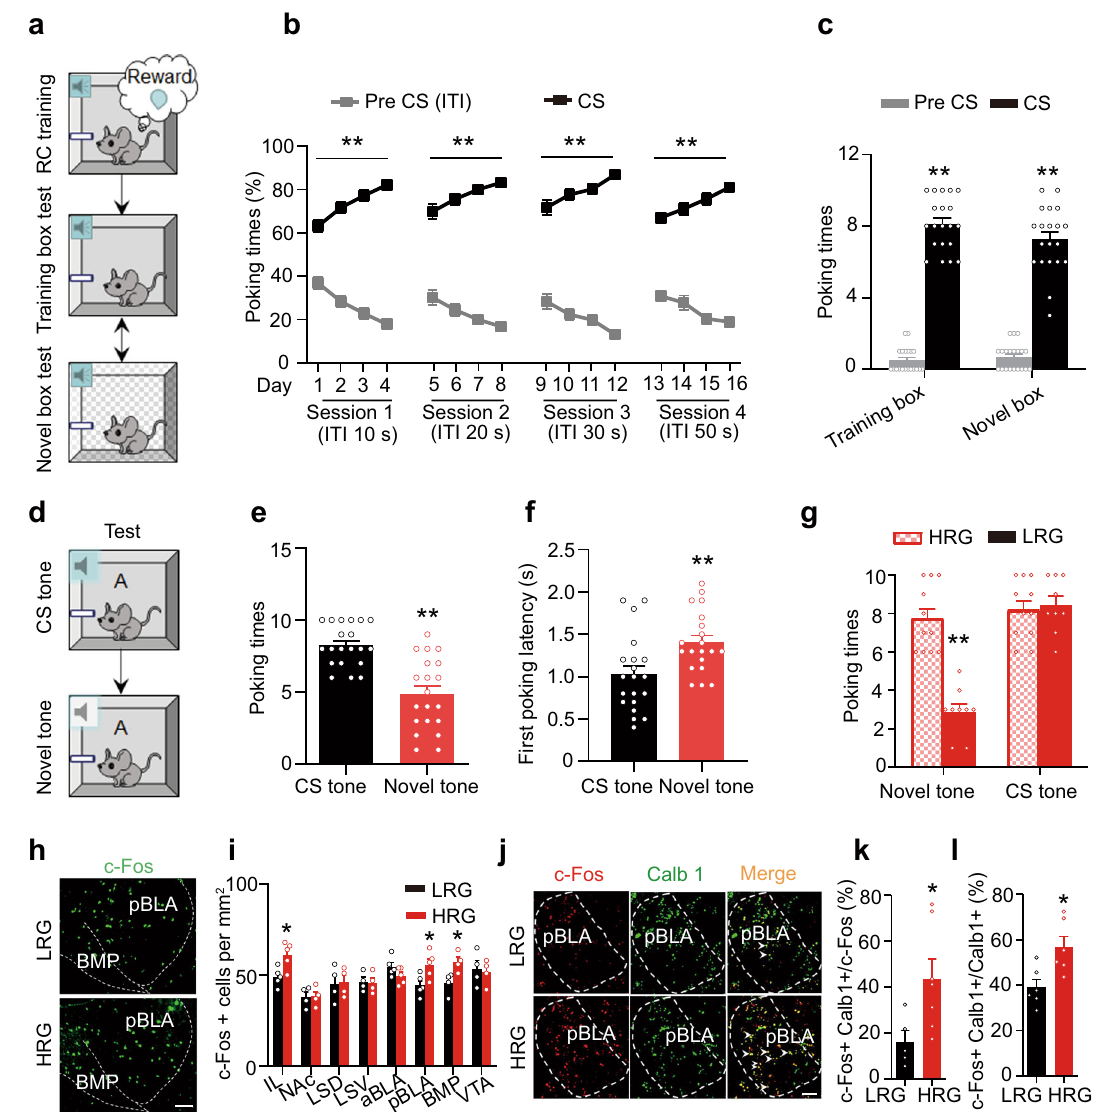
Fig. 1 | High reward generalization for ambiguous cues is associated with robust activation of pBLA Cab1 neurons. a Schematic of reward conditioning (RC) training and test. b RC training improved association of CS tone with predicted sucrose. ITIs: inter-trial intervals. Repeated measures two-way ANOVA, [Session 1]: F(3,57)=56.40, P <0.0001;[Session2]:F(3,57)=31.82, P <0.0001;[Session3]:F(3, 57)=30.49, P <0.0001; [Session 4]: F(3, 57)=33.63, P <0.0001,Tukey ’ s multiple comparisonstest,** P <0.01vsPreCS(ITI). c CStonesinducedanincreasedpoking time in both training and novelbox. n =20 micepergroup. [Training box]: t =18.7, df =19, P <0.0001; [Novel box]: t =15.38, df =19, P <0.0001. ** P <0.01 vs Pre CS. d Schematic for ambiguous cue test. e , f CS-trained mice displayed generalization to ambiguous cues. n =20 mice per group. [Poking times]: t =4.876, df =19, P <0.001; [First poking latency]: t =3.370, df =19, P =0.0032. ** P <0.01 vs CS tone.